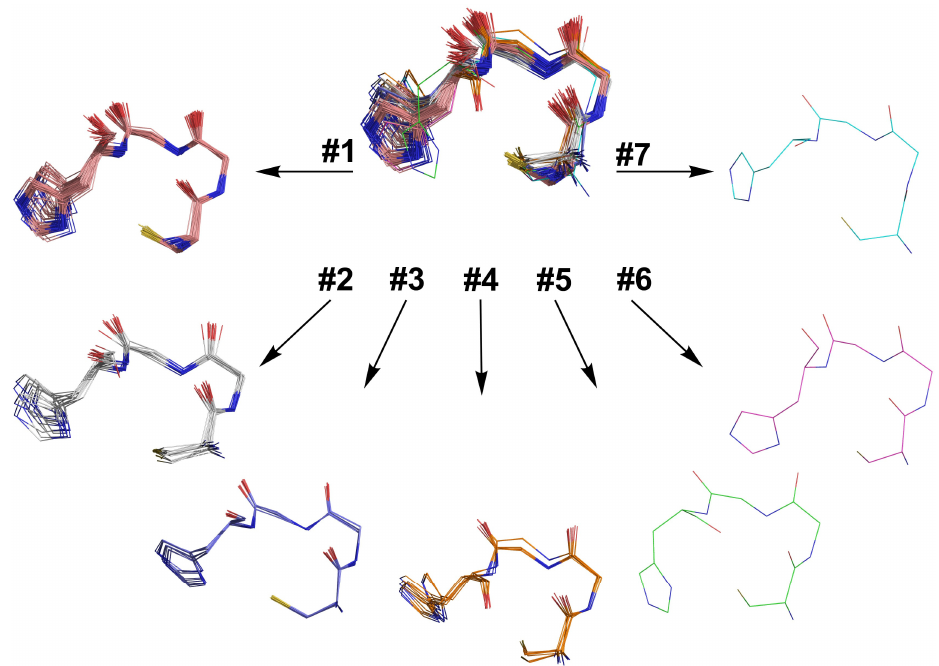
Figure 7. Superimposed C-X 1 -X 2 -H-X 3 motifs as obtained from the clusterization procedure.